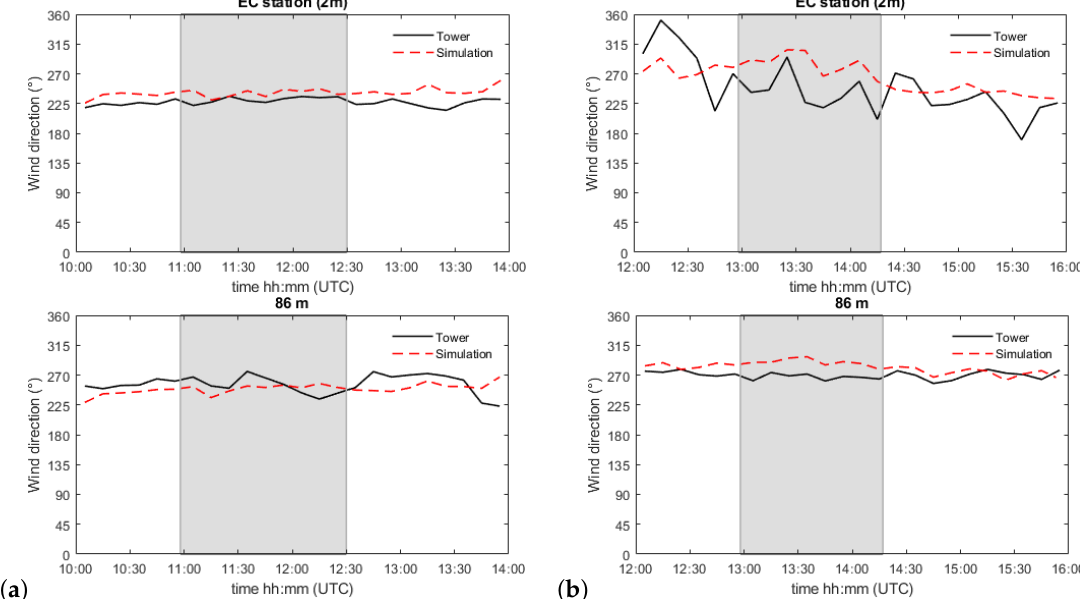
Figure 4. Time series of 10-min averages of wind direction at 2 m and 86 m a.g.l. on 21 ( a ) and 22 ( b ) September. See also Figure